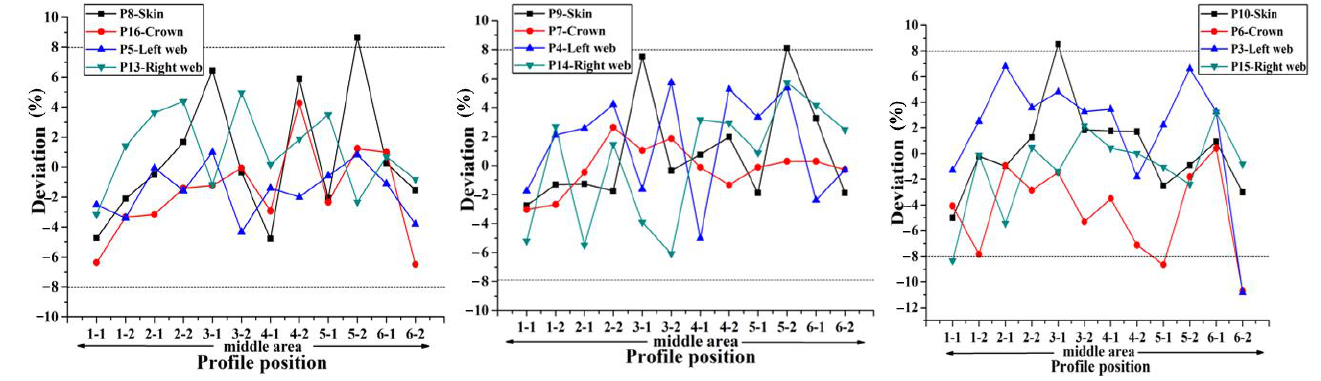
Figure 14. Comparison of dimensional stability of stringer manufactured by 50 HA bladder.